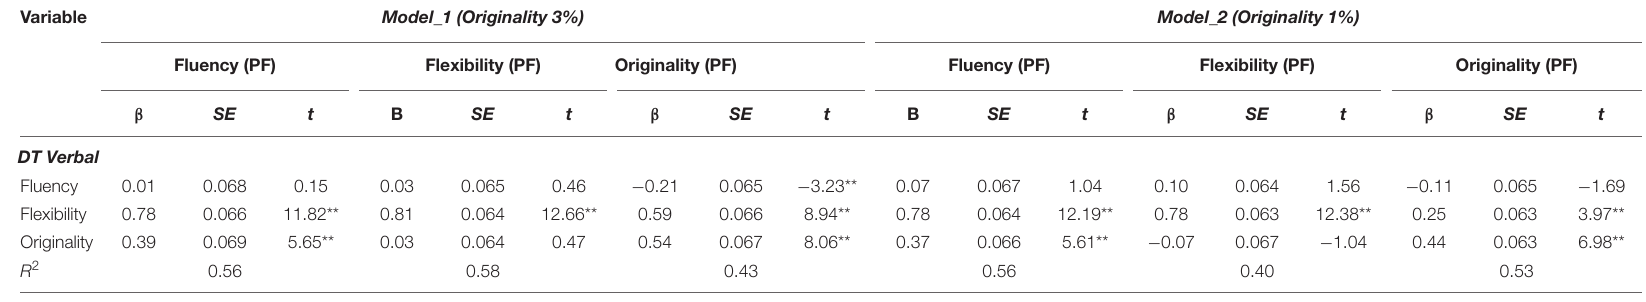
TABLE 6 | Path analysis of DT indices with PF.